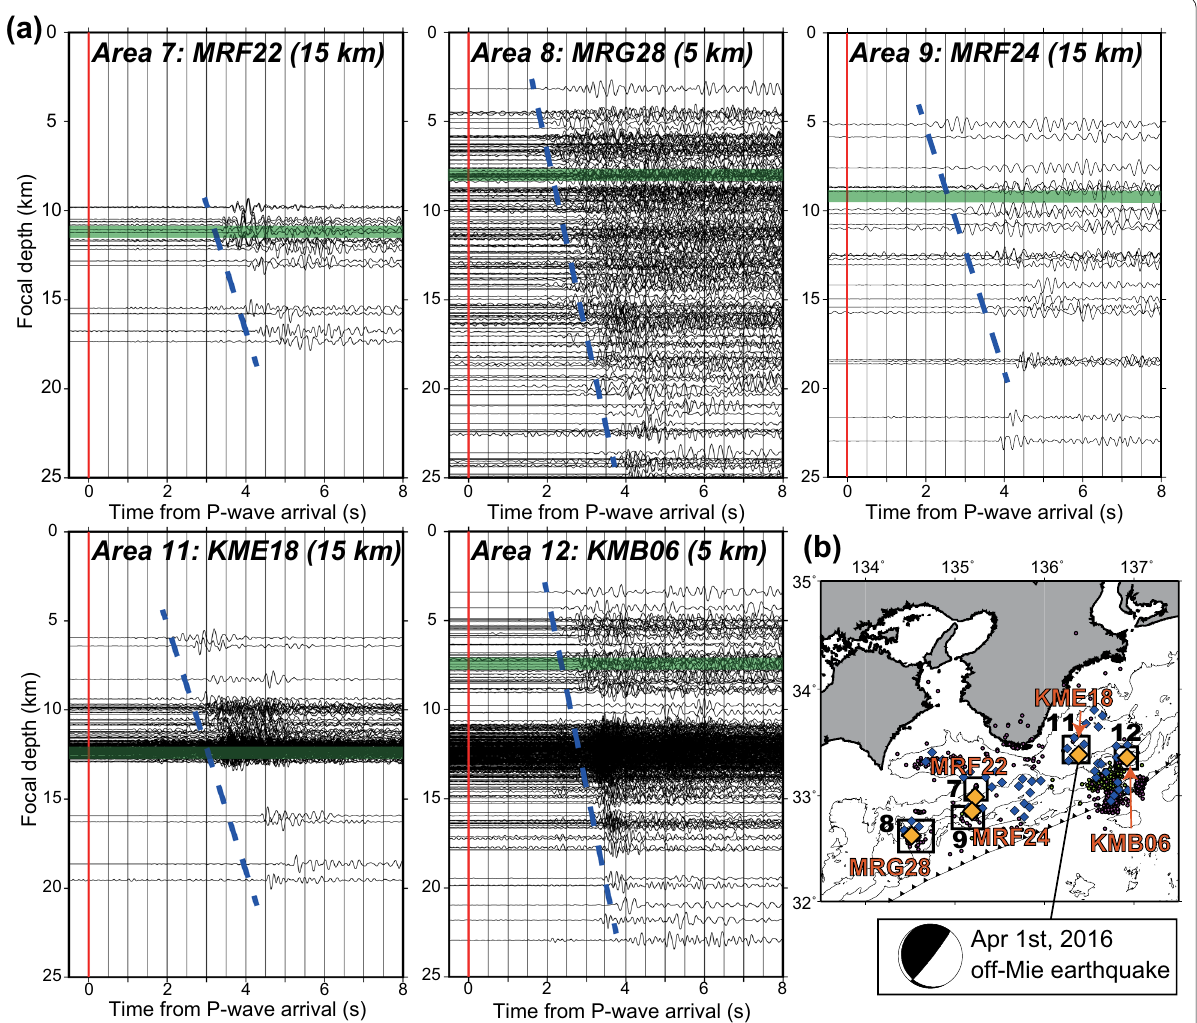
Fig. 14 Observed waveforms in the vicinity of each station. a Examples of the observed waveform (horizontal component) whose focal depth is larger than the epicentral distance with respect to the hypocenter depth. The maximum epicentral distance for each station is shown in each figure. All waveforms are aligned by the P-wave arrival time. Blue lines show the approximate straight line of the S-wave arrival time. The thick green line shows the depth of the plate interface beneath each station. b Station locations shown in a . The focal mechanism solution for the 2016 off-Mie earthquake is also